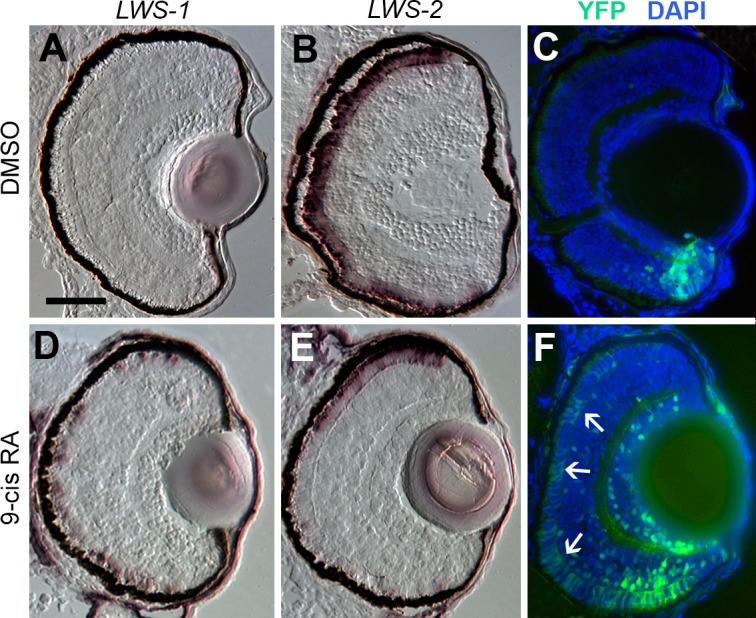
Spatial relationship of RA signaling activity compared with expression of LWS1 and LWS2.A-C. Sections obtained from a RARE:YFP transgenic embryo treated with DMSO 48 hpf-100 hpf, then labeled for LWS1 mRNA expression (A), LWS2 mRNA expression (B), or YFP immunofluorescence (C; counterstained with DAPI). D-F. Sections obtained from a RARE:YFP transgenic embryo treated with 0.3 μM 9-cis RA 48 hpf– 100 hpf, then labeled for LWS1 mRNA expression (D), LWS2 mRNA expression (E), or YFP immunofluorescence (F). Expanded RA signaling domain (arrows) is similar to the LWS1 expression domain. Scale bar in A (applies to all) = 50 μm.